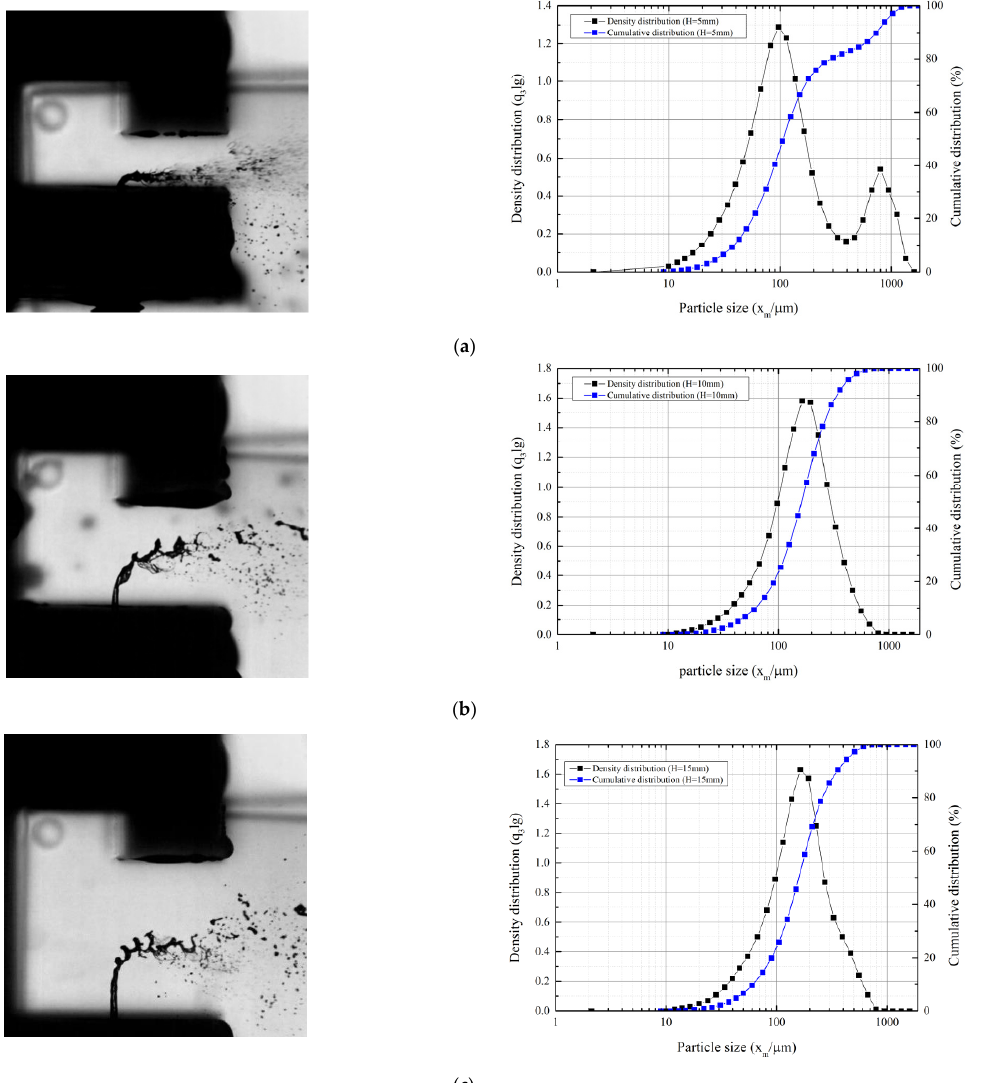
Figure 16. Instantaneous images and particle diameter distribution for H / d 0 = 10, 20, and 30, We l = 179 and air mass flow of 46 g/s: ( a ) H / d 0 = 10, We a = 45; ( b ) H / d 0 = 20, We a = 28; and ( c ) H / d 0 = 10, We a = 5.